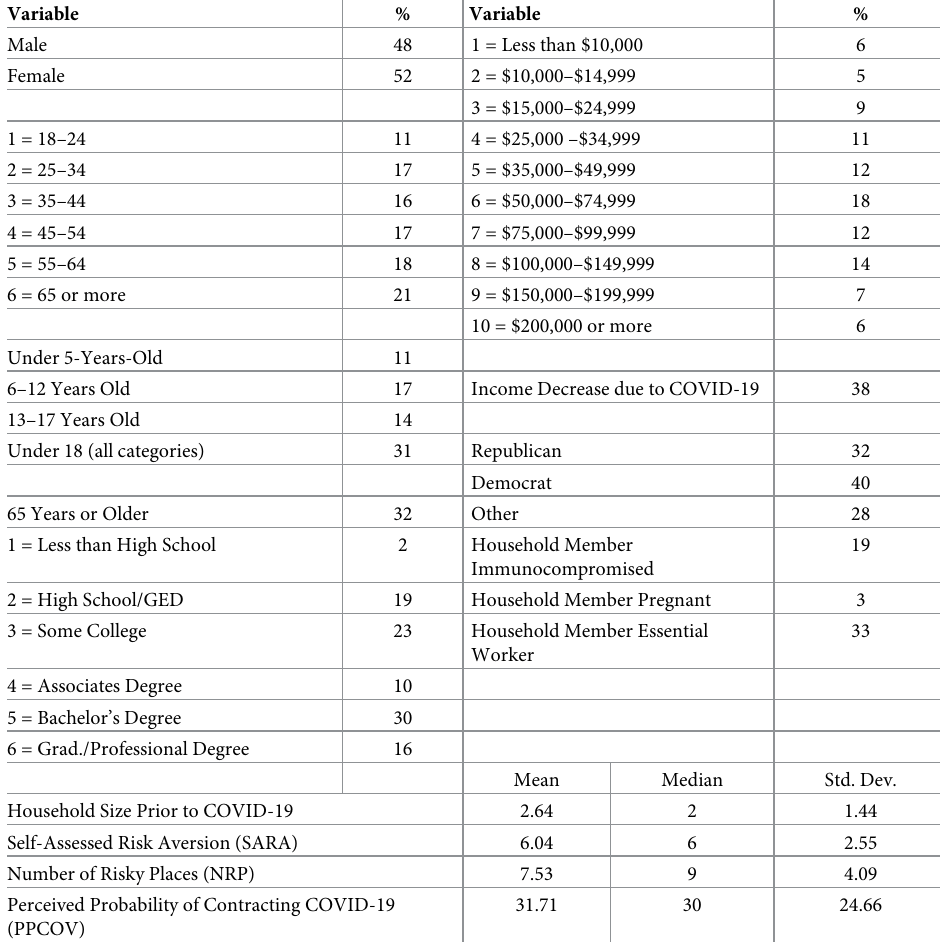
Table 1. Summary of demographic and behavioral characteristics (n =